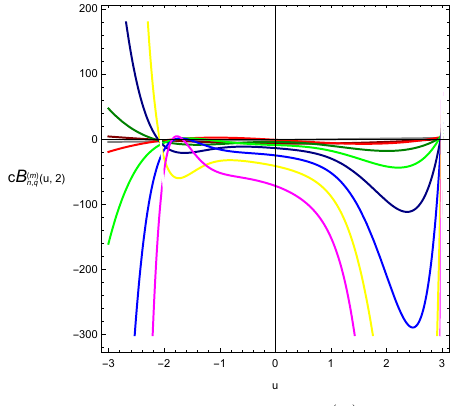
Figure 1. Curve of q GTBP C B